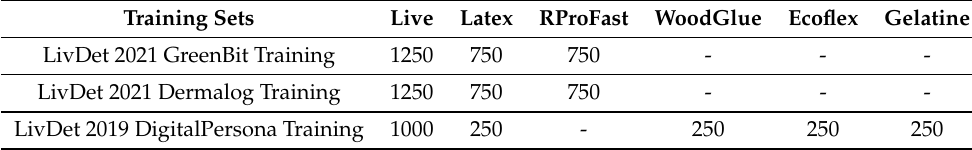
Table 3. Number of samples for each scanner employed in the training